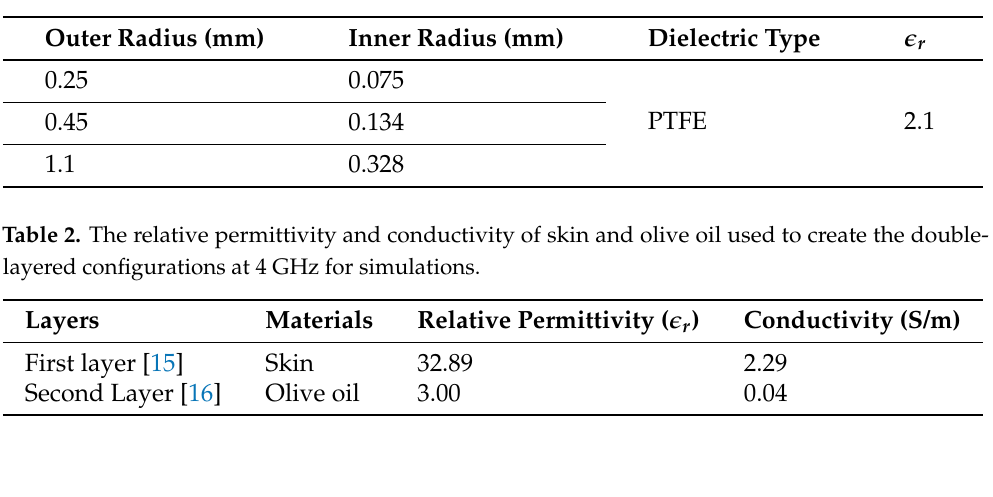
Table 1. Simulated probe dimensions with different aperture sizes.